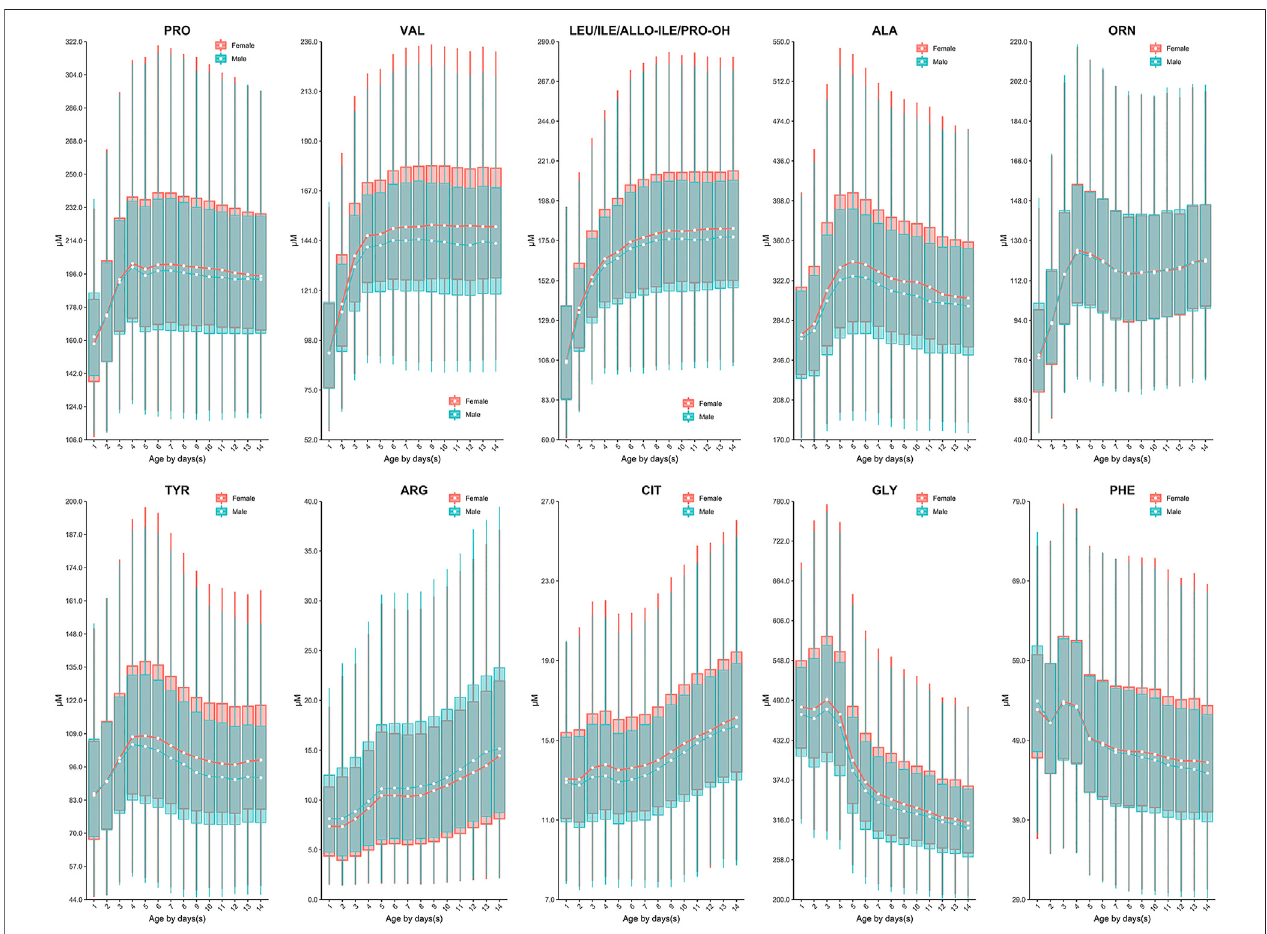
FIGURE 2 | The dynamic change of amino acids except methionine over age and sex. Data of male and female partitions are shown in green and red boxes with whiskers,respectively.Theboxesextendfromthe25 th tothe75 th percentile,withwhiskersextendingtothe2.5 th or97.5 th percentile.Mediansareshownaswhitecircles in the body of boxes, and are linked with green (male) or red (female) line to shown the dynamics. Abbreviations are listed in the legend of Table 2 .